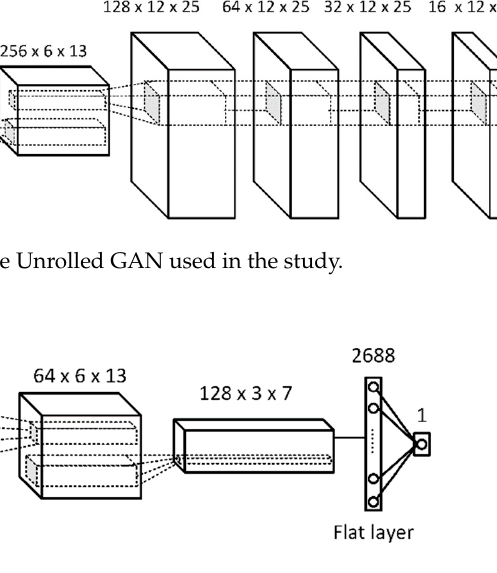
Figure 10. Discriminator (cid:1830) of the Unrolled GAN used in the study.